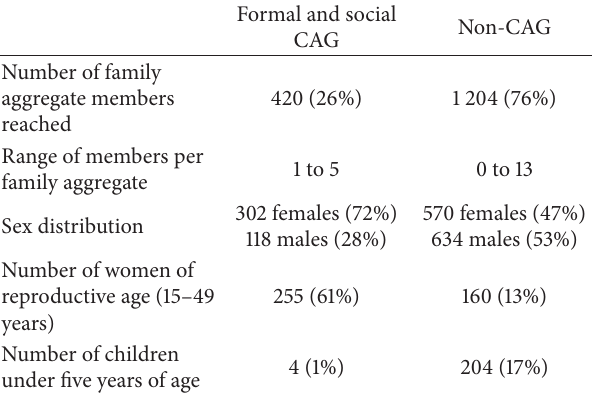
Table 1: Demographic characteristics of the